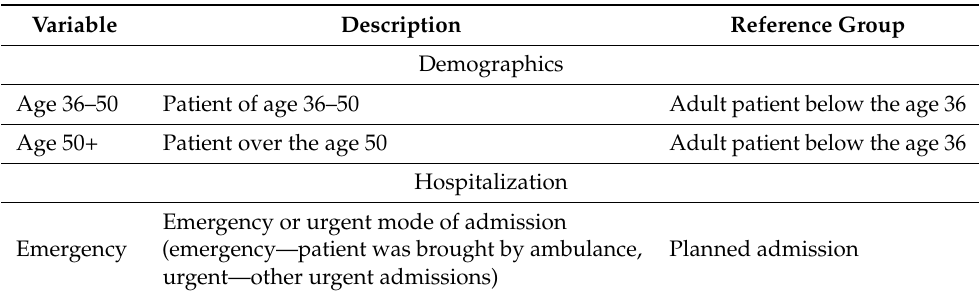
Table 2. Variables that were used only for modeling rehospitalization within 90 days after discharge.